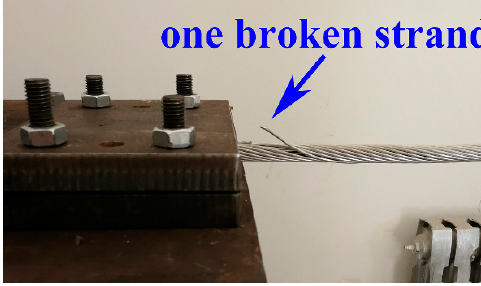
Figure 4. Broken strand location.